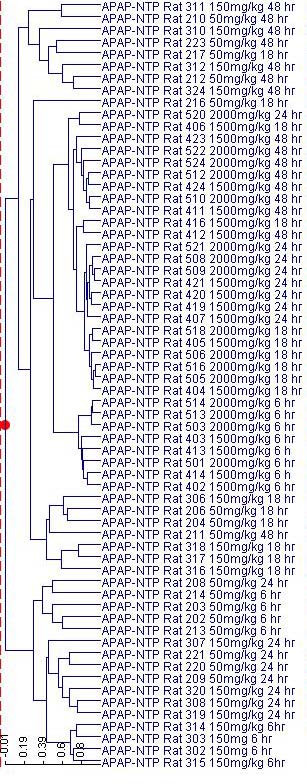
Hierarchical clustering of the biological samples. Log10 transformed gene expression ratio values of the 82 genes from the prototypes of the clusters of the biological samples were subjected to agglomerative hierarchical clustering using cosine correlation as the similarity measure and average linkage methodology. The branches of the dendrograms represent the amount of similarity between clusters of samples.